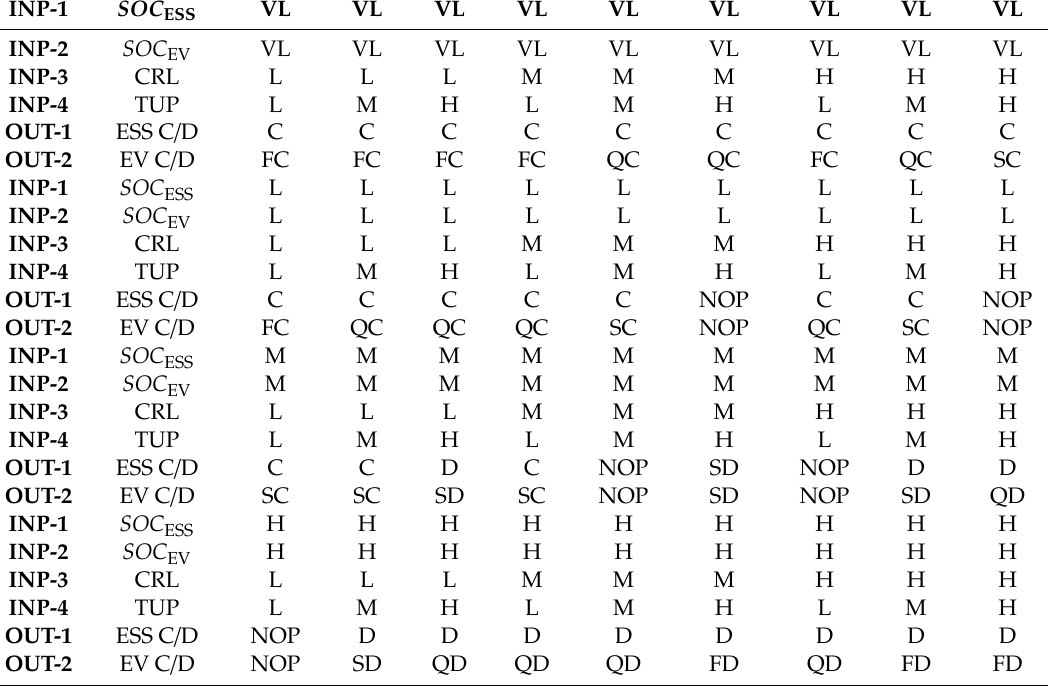
Table 5. Fuzzy set rules to obtain EVs and ESS charging/discharging pattern.